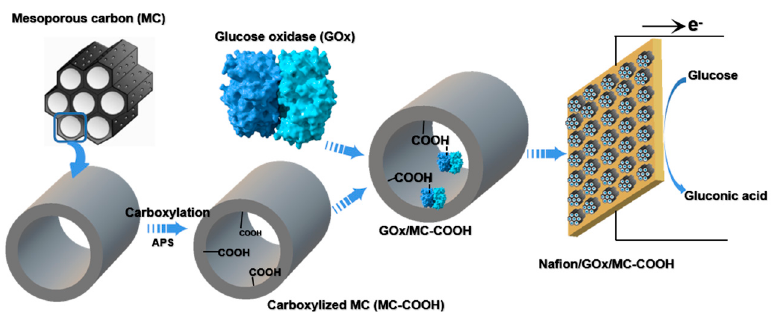
Figure 1. Experimental scheme of mesoporous carbon (MC)-COOH preparation and enzyme immobilization.